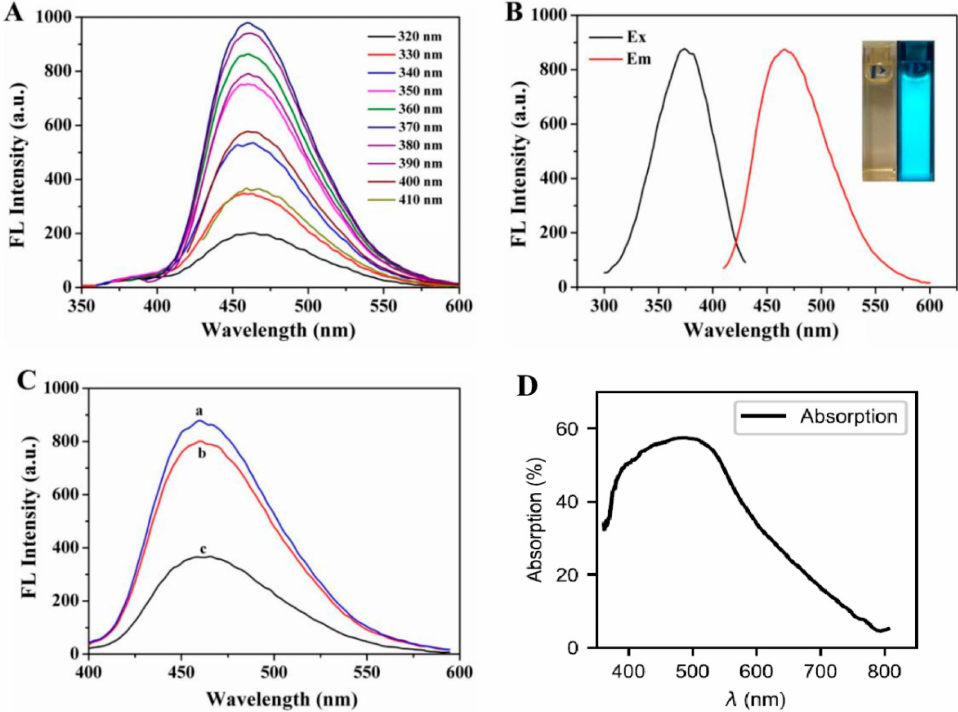
Figure 8. ( A ) FL emission spectra of MCOFs@MIPs@CDs with various excitation wavelengths (320–410 nm). ( B ) Maximum FL excitation and emission spectra of MCOFs@MIPs@CDs. The